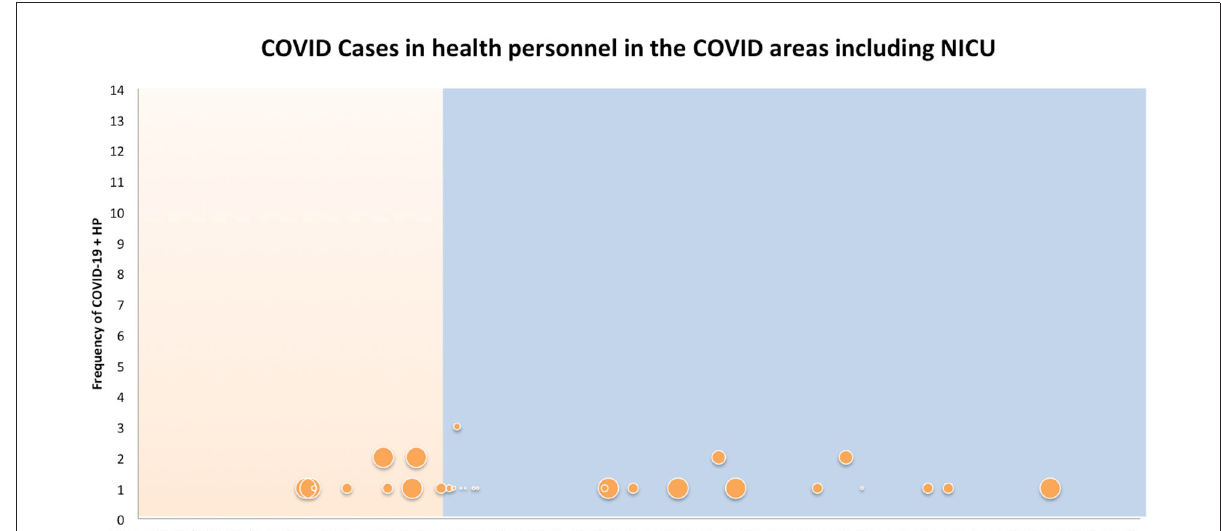
FIGURE1 Orange and blue shades represent period 1 and 2 respectively. The size of the circles indicates the percentage of COVID-19 and HP tests. The large circles represent 100%, the medium circles 50% and the small ones 30%.